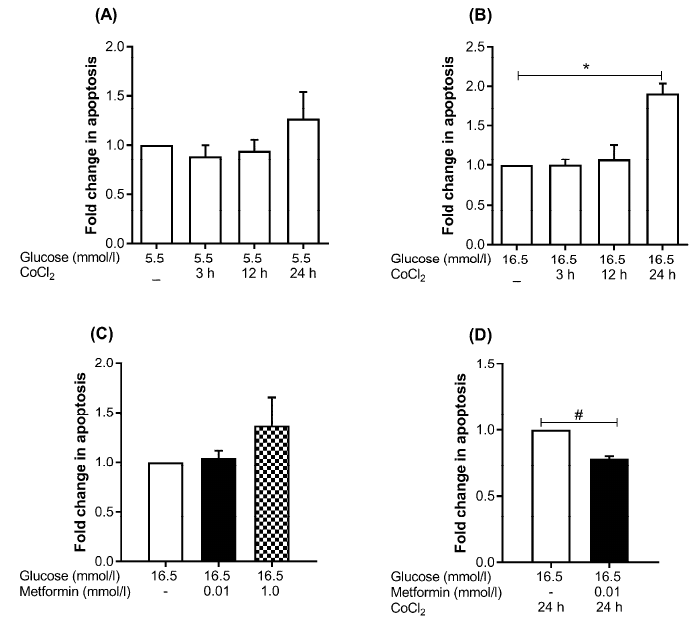
Figure 3. Metformin improves cell survival with hyperglycemia-CoCl 2 . ( A ) HUVEC were treated